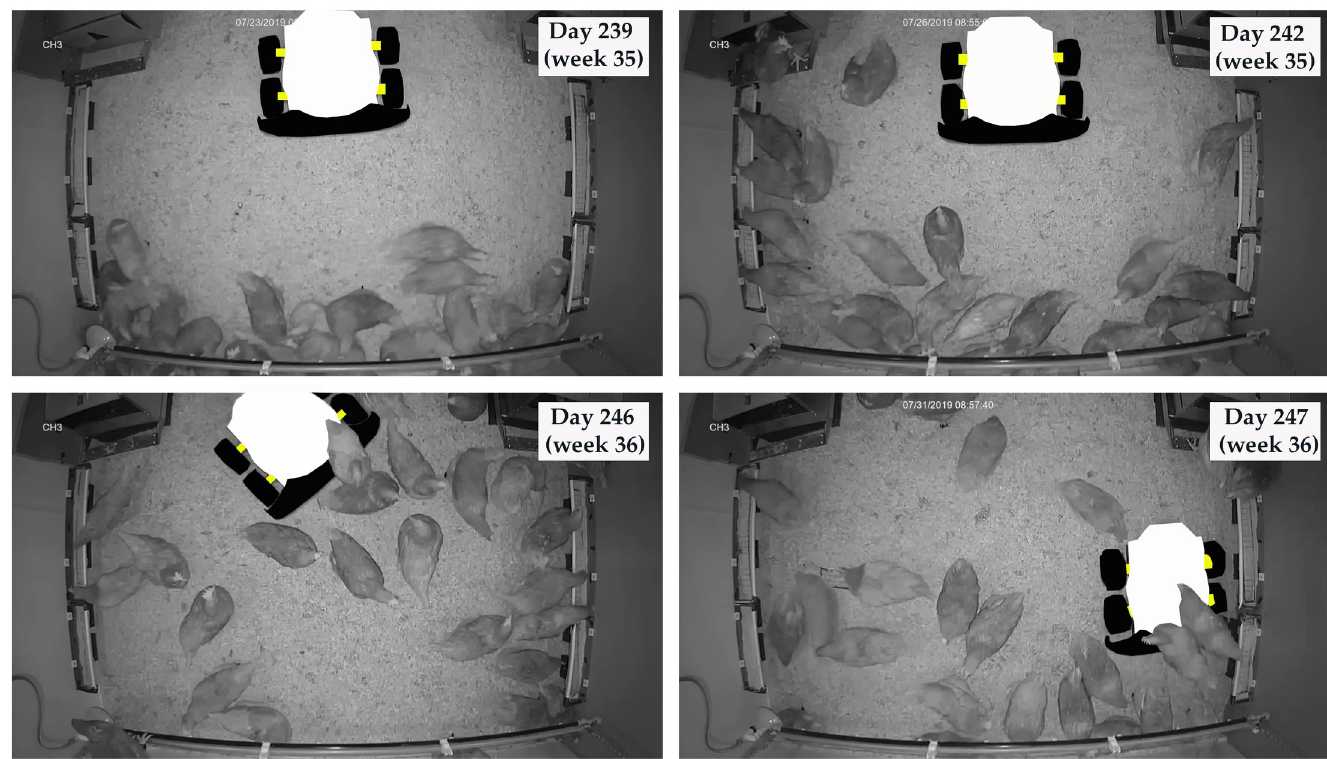
Fig 7. Example pictures of hen-robot interactions for a pen with two-week robot running in phase 1 (weeks 35–38).